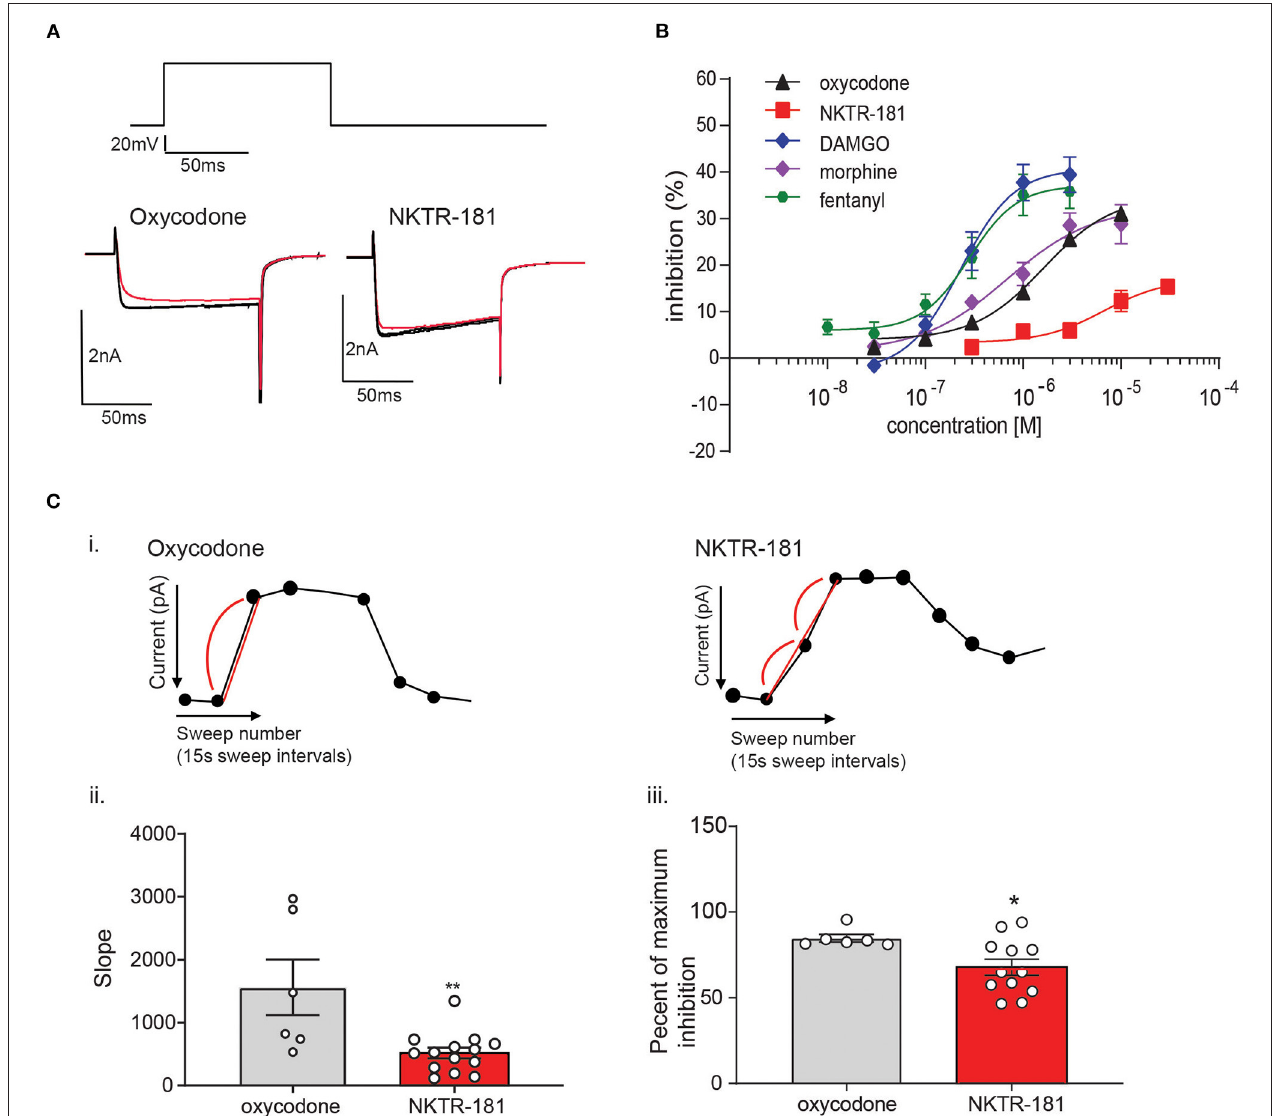
FIGURE 1 | The profile of NKTR-181 inhibition of voltage-activated calcium channel currents (VACCs) in dorsal root ganglia (DRG) neurons. (A) Inhibition of VACCs was measured in dissociated and cultured adult DRG neurons. The current was obtained by a step voltage protocol from the holding voltage of open the Ca 2 + channels, as shown in the top panel. This step protocol is repeated every 15s to obtain a baseline Ca 2 + current amplitude, after which mu opioid receptor (MOPr) agonist such as oxycodone or NKTR-181 is applied (shown in red) to inhibit the VACCs, and the agonist is then washed off. (B) In comparison with known MOPr agonists, NKTR-181 is both less efficacious and potent in this assay ( Table 1 ). (C) Rate of inhibition. [C(i)] These exemplar recordings of the change in amplitude across time (each dot represents a 15s sweep interval) induced by oxycodone (10 µ M) or NKTR-181 (30 µ M) were analyzed to obtain the rate of inhibition and the percentage inhibition obtained during the first sweep interval. NKTR-181 inhibited VACCs more slowly than oxycodone [C(ii)]; ** p < 0.01 vs. oxycodone and obtained less percentage inhibition over time [C(iii)]; * p < 0.05 vs. oxycodone. Data are shown as mean for